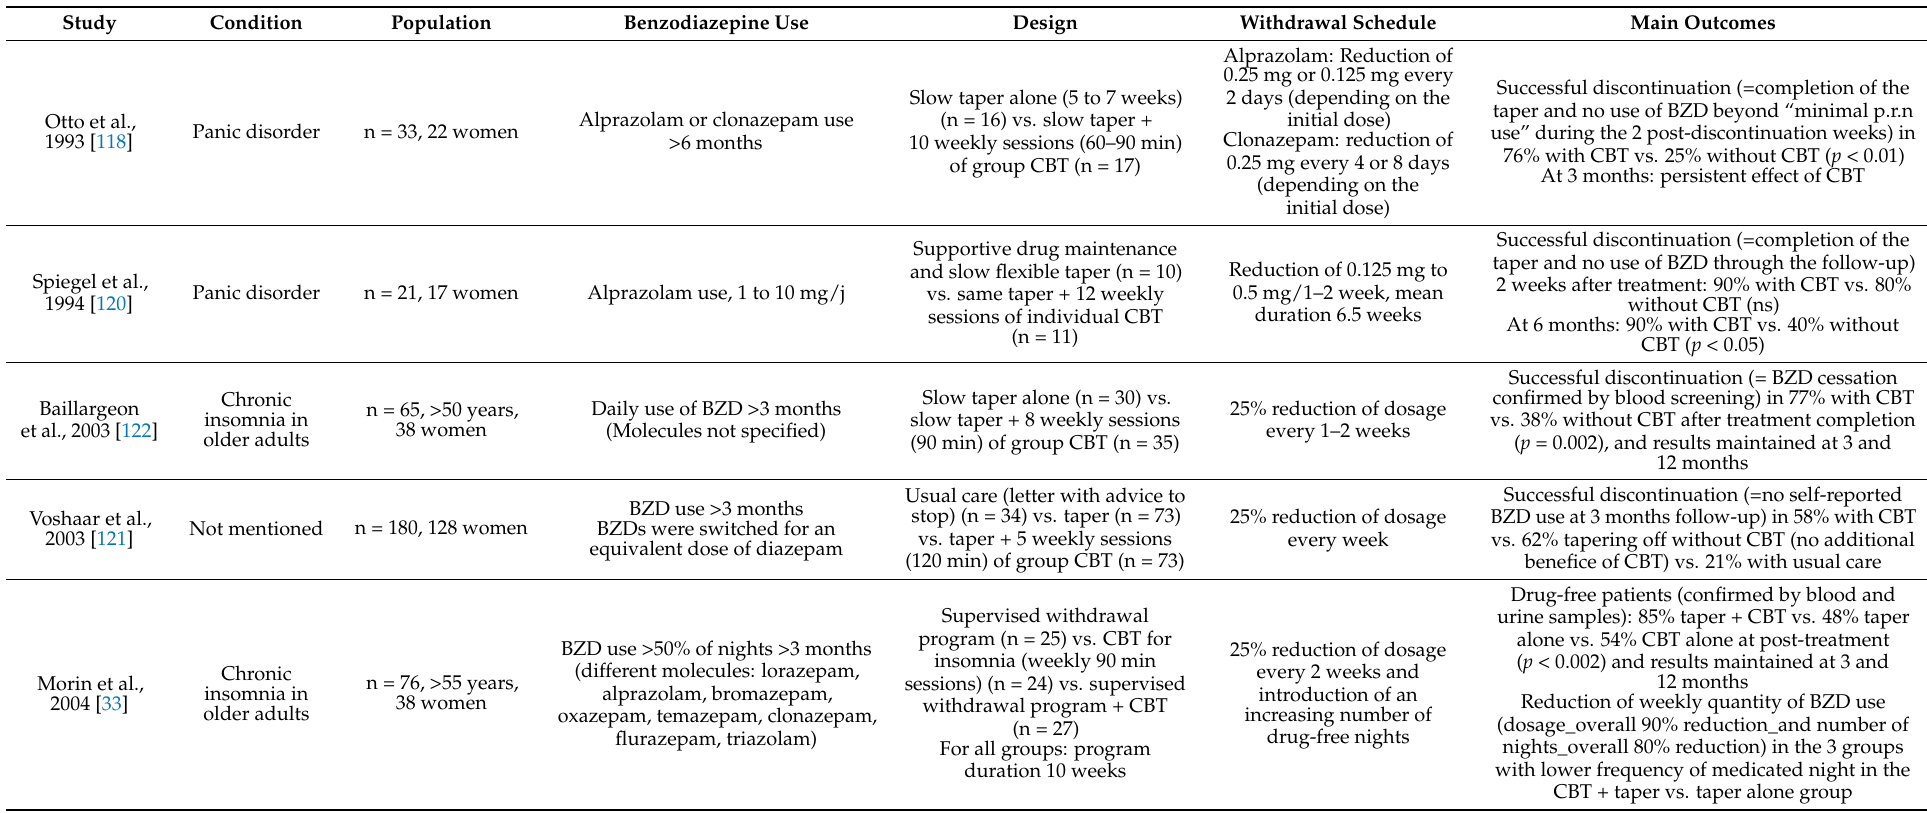
Table 1. Randomized Controlled Trials comparing the effectiveness of a taper program alone versus a taper program associated with